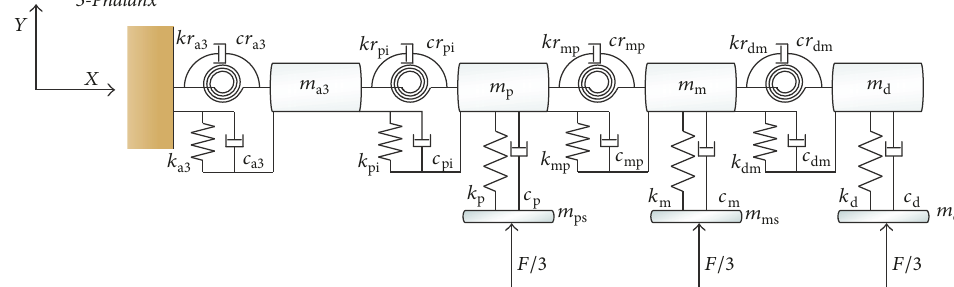
Figure 4: The model configuration used for the distal, middle, and proximal finger phalanxes (denoted as 3-Phalanx).